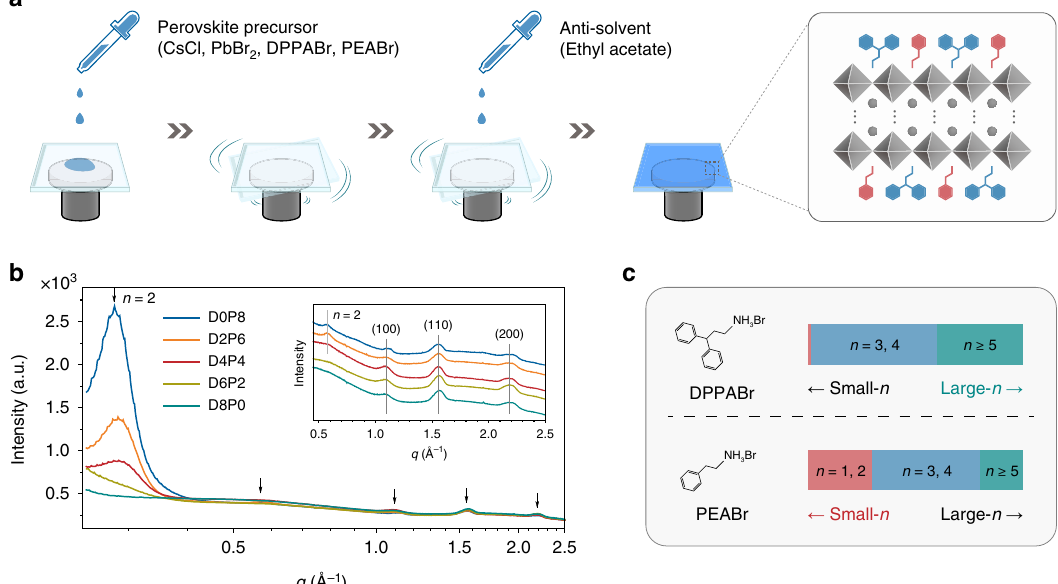
Fig. 1 Structural characterizations of the CsPbClBr 2 nanocrystal fi lms. a Schematic illustration of the in situ fabrication process for CsPbClBr 2 nanocrystal fi lms. b The integrated intensity- q relations of GIWAXS patterns for the CsPbClBr fi lms with different ratios between DPPABr and PEABr. 2 nanocrystal Inset: partial enlarged intensity- q curves (0.45 – 2.5 Å − 1 ). c Schematic diagram of QWD for DPPABr-only and PEABr-only CsPbClBr 2 nanocrystal fi lms.